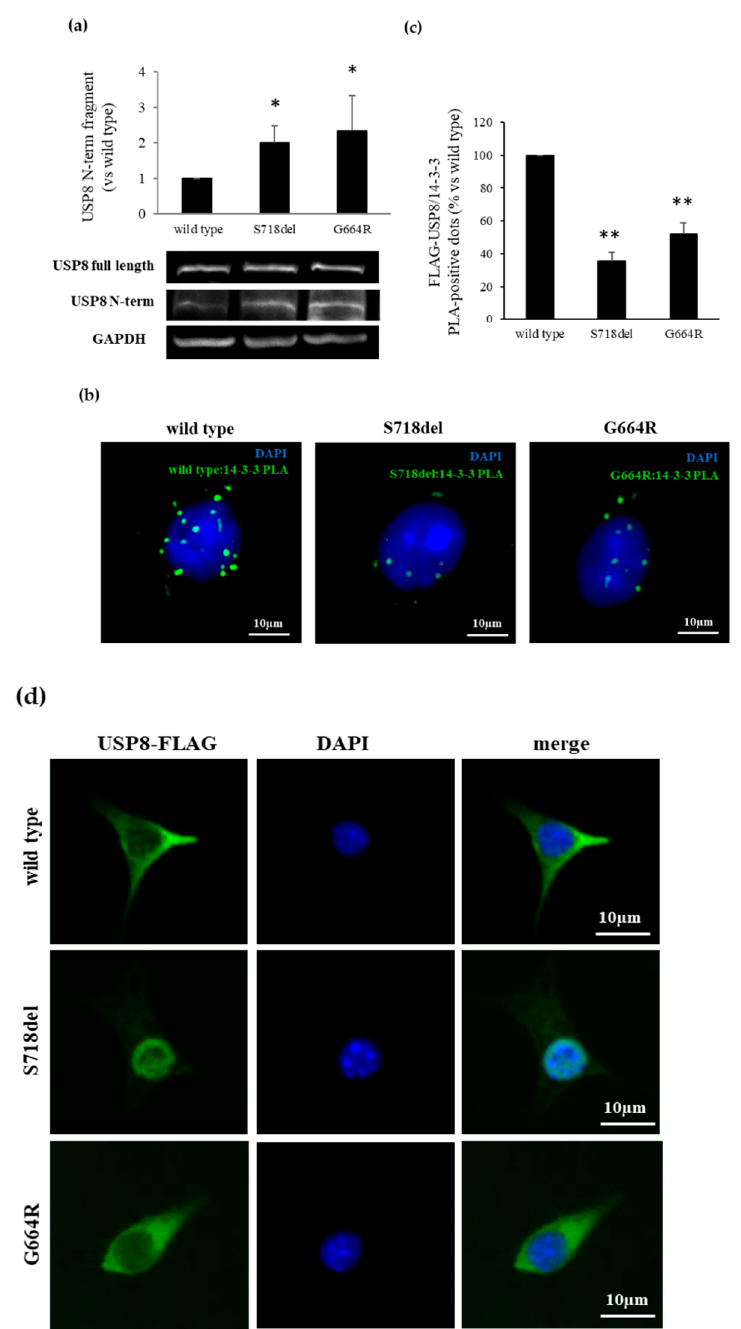
Figure 3. G664R substitution increases proteolytic cleavage of USP8 hampering its interaction with 14-3-3 proteins. ( a ) Representative Western blot experiment and densitometrical analysis showing enhanced USP8 N-term fragment production in AtT-20 cells transfected with G664R USP8 mutant. *, p < 0.05 vs. WT USP8 transfected cells ( b ) Representative in situ PLA experiment performed in AtT-20 cells transfected with USP8 mutants. AtT-20 cells were incubated with anti-FLAG and anti-14-3-3 antibodies, respectively. Mouse anti-FLAG and rabbit anti-14.3. probes were used, respectively. Each picture represents a typical cell staining observed in 10 fields randomly chosen. Green dots represent PLA events and indicate close proximity between USP8 and 14-3-3 proteins. Cell nuclei are stained in blue with DAPI. Scale bars 10 µ m. ( c ) Quantification of total USP8/14-3-3 puncta representing PLA events as shown in ( b ), showing a decrease in USP8/14-3-3 interaction in G664R USP8